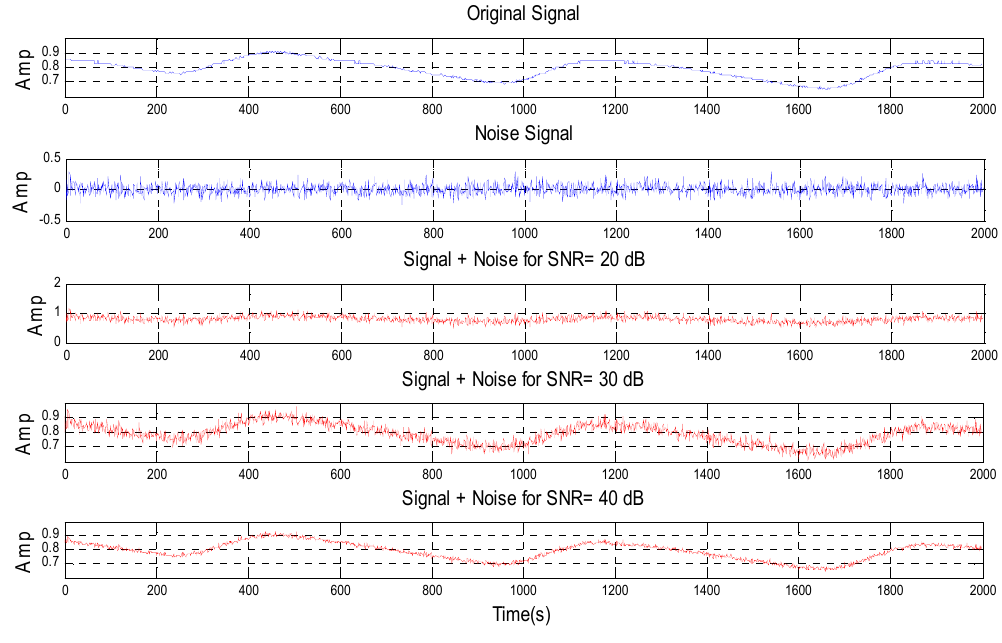
Figure 7. The characteristic of the new data samples.